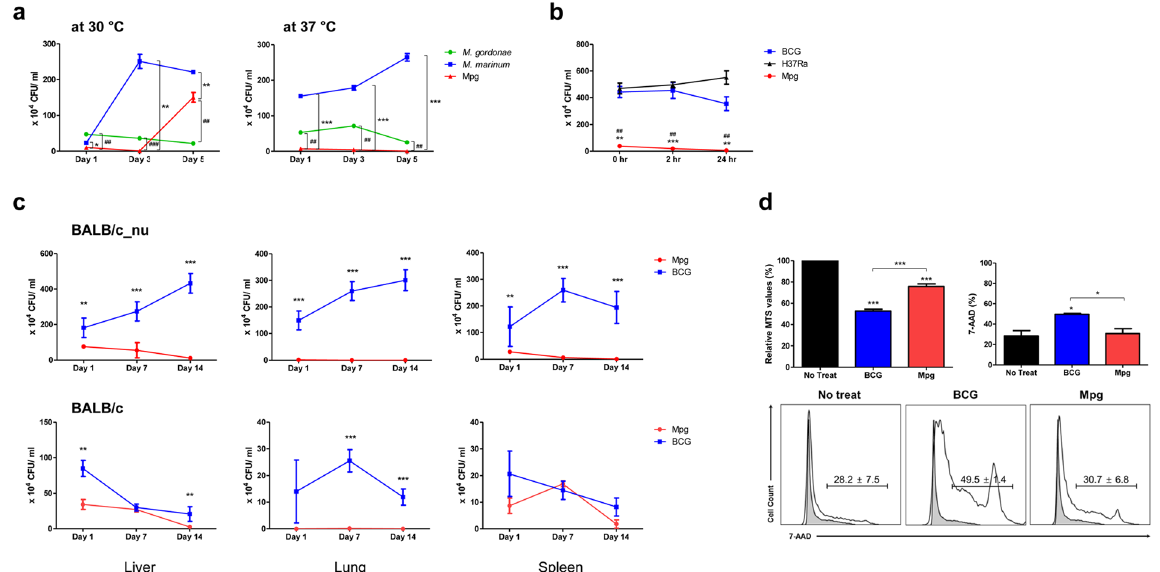
Figure 1. M. paragordonae (Mpg) led to the attenuated infection into murine macrophage and in an in vivo mice system. ( a ) Survival test of M. gordonae , M. marinum and Mpg strains (10 M.O.I. infection) at 30 °C (left) and 37 °C (right) in the murine macrophage J774.1. ( b ) Survival test of M. bovis BCG (BCG), Mpg and M. tuberculosis H37Ra (H37Ra) (10 M.O.I. infection) in the murine macrophage J774.1 at 37 °C in early time point (0, 2, and 24 hours). ( c ) Growth of BCG and Mpg in the organs (lungs, liver and spleen) after intravenous inoculation into BALB/c_nu (nude, up panels) and BALB/c (down panels) mice (n = 3–4 per group) ( * P < 0.05, ** P < 0.01, *** P < 0.001; Student’s t -test). ( d ) The viability of BMDCs was measured by MTS and 7-AAD staining assay after infection with 10 M.O.I. of BCG or Mpg overnight. Representative histograms of 7-AAD are presented ( ** P < 0.05, *** P < 0.001; Student’s t -test). All data are mean ± standard deviation of CFU or intensity values in each